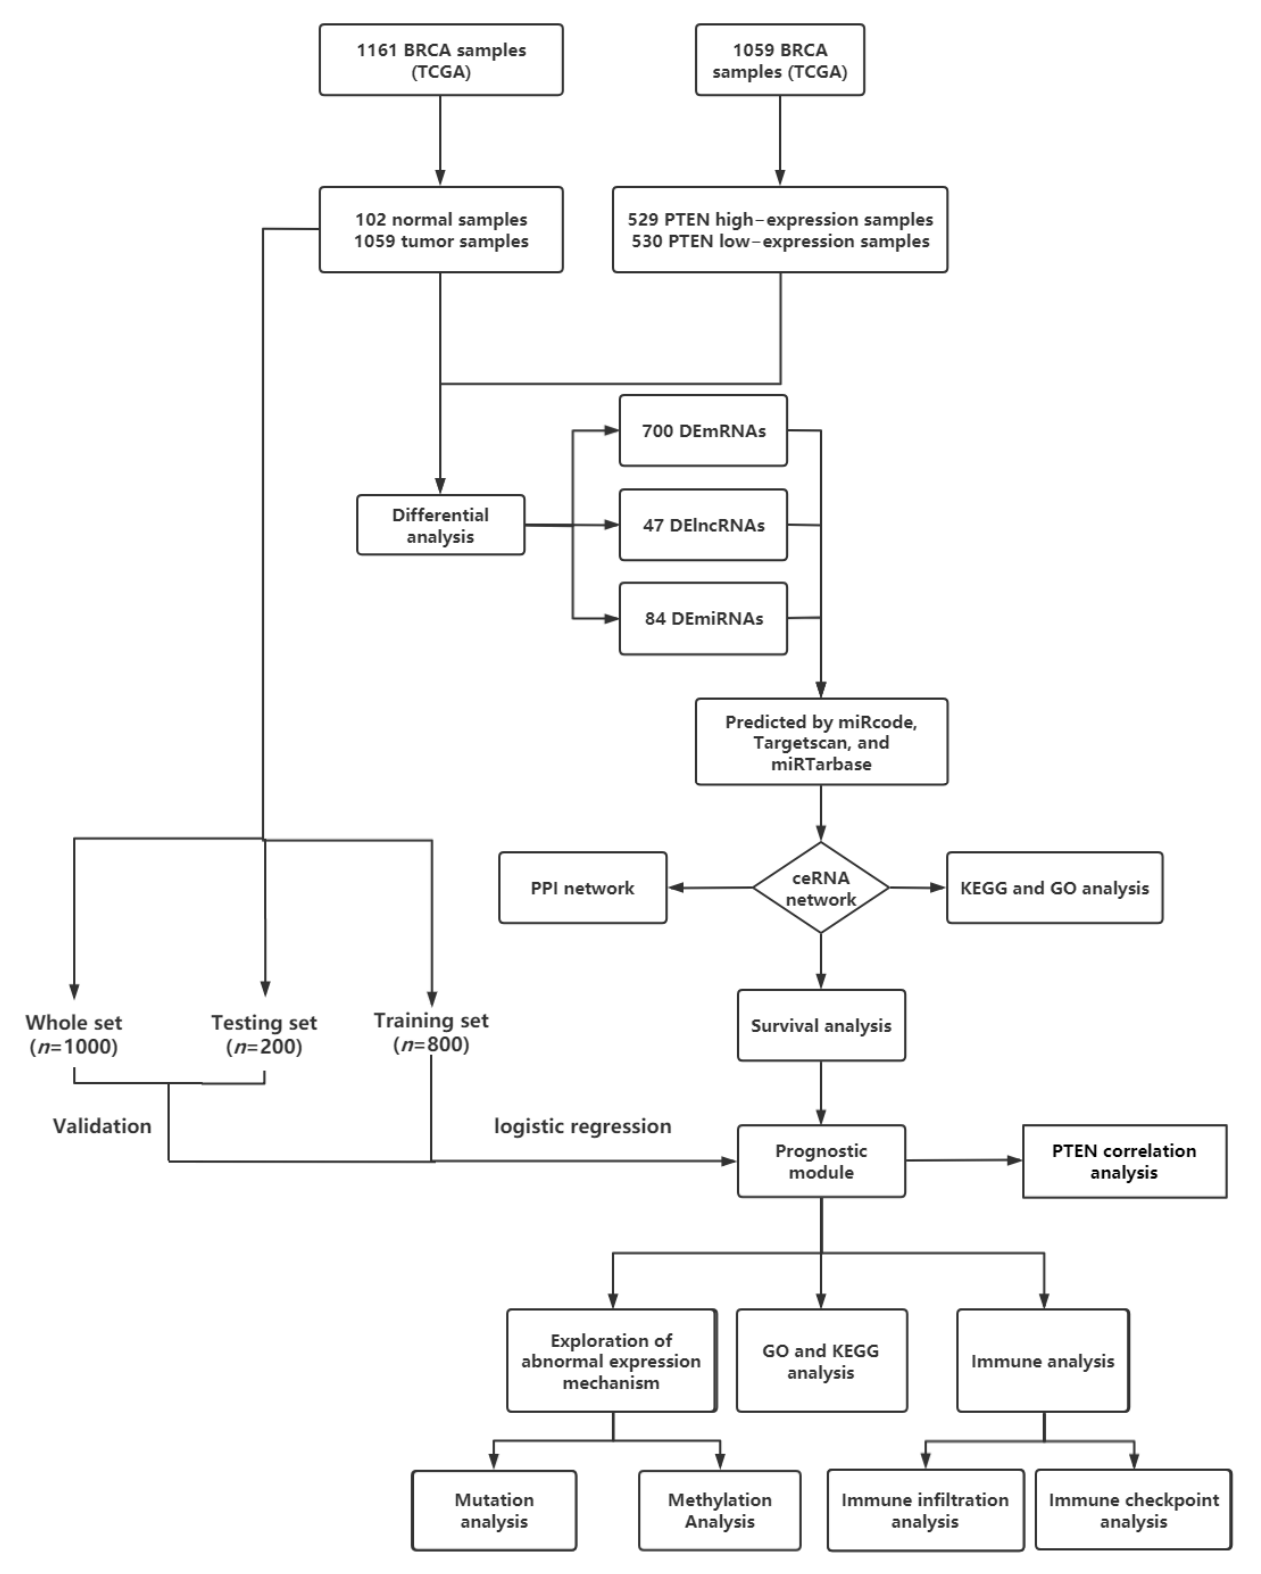
Figure 1. Flowchart of construction and analysis of ceRNA network .